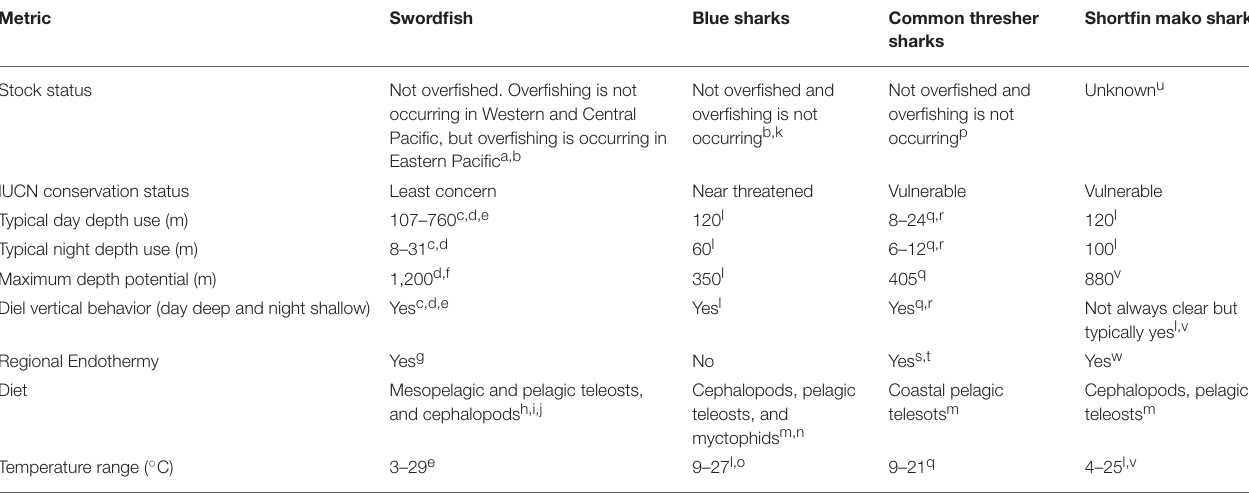
TABLE 1 | Ecological comparison of swordfish, blue sharks, common thresher sharks, and shortfin mako sharks based on published sources.